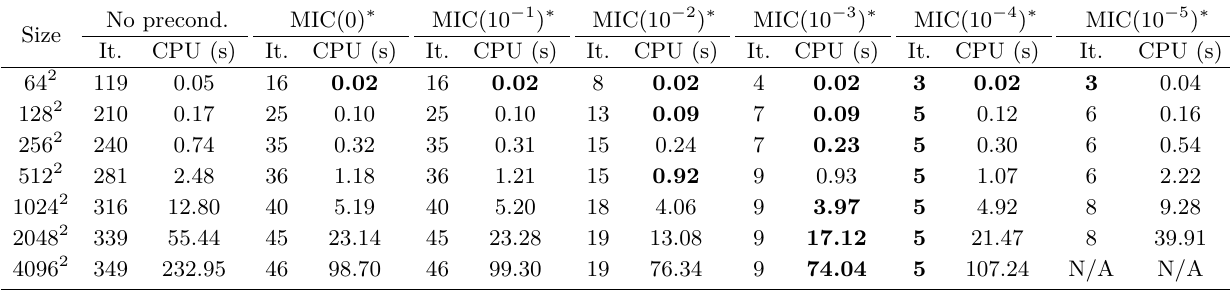
Table 6 Number of iterations and CPU time for applying the PCG algorithm, starting from the FM solution rather than from the trivial state. The indicated CPU time includes the time for computing the FM initialisation. Using FM as an initial guess saves many computations: the time to solve the 4096 2 problem is reduced from 26 min (with neither FM initialisation nor preconditioning, see second column in Table 5, to 1 min (with FM initialisation and preconditioning, see column 6) No Size